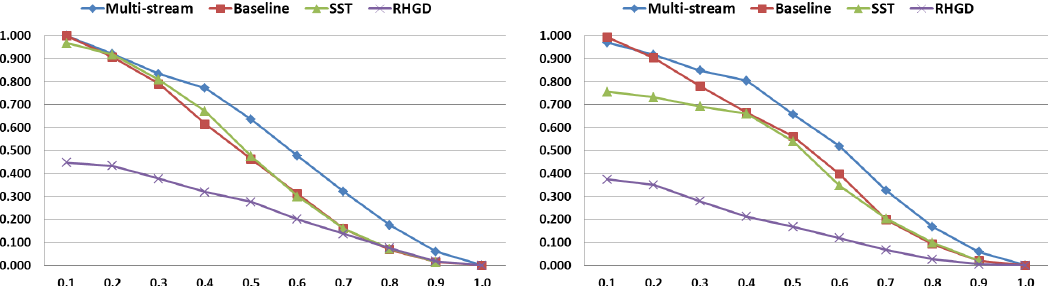
Figure 10. Results comparison of our approach with previous methods, such as SST [26] and real-time hand gesture detection (RHGD) [39]. X -axis defines the different tIoU thresholds, and y -axis the AR score. ( left ) Validation results. ( right ) Testing